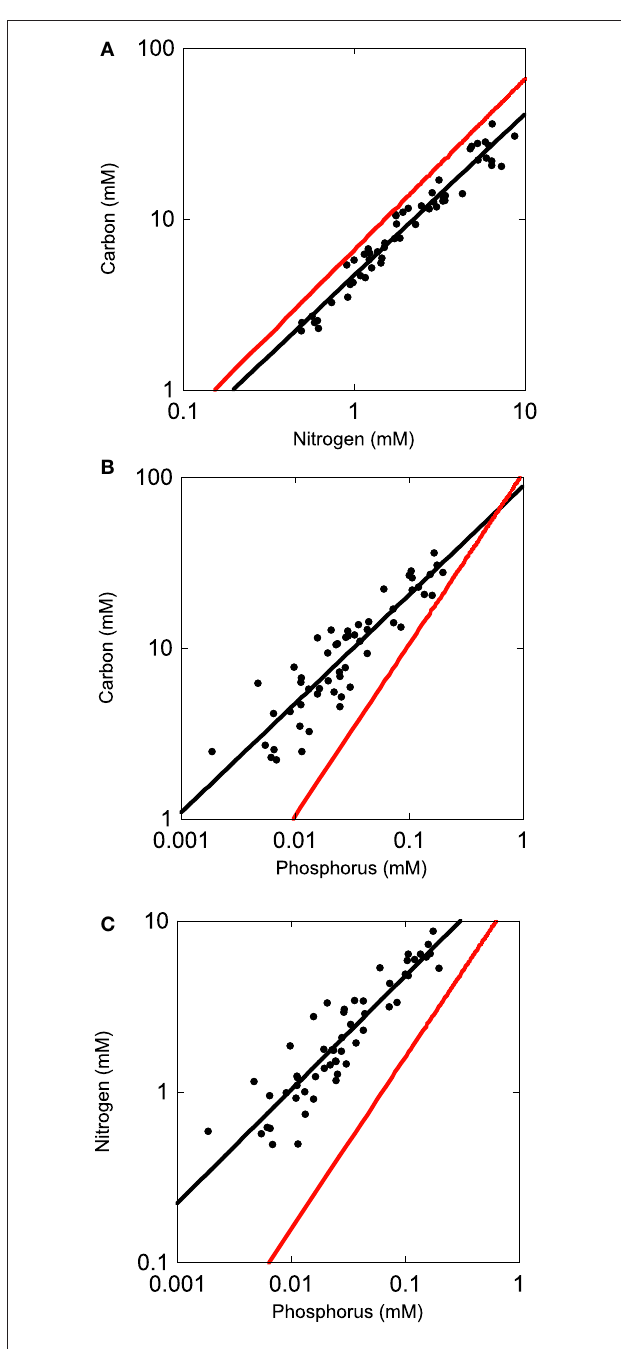
Figure 2 | regressions (SMA) of organic carbon, nitrogen, and phosphorus content in bacterial isolates from several lakes in and near itasca State Park, MN, uSA (Long Lake, elk Lake, and Lake itasca).